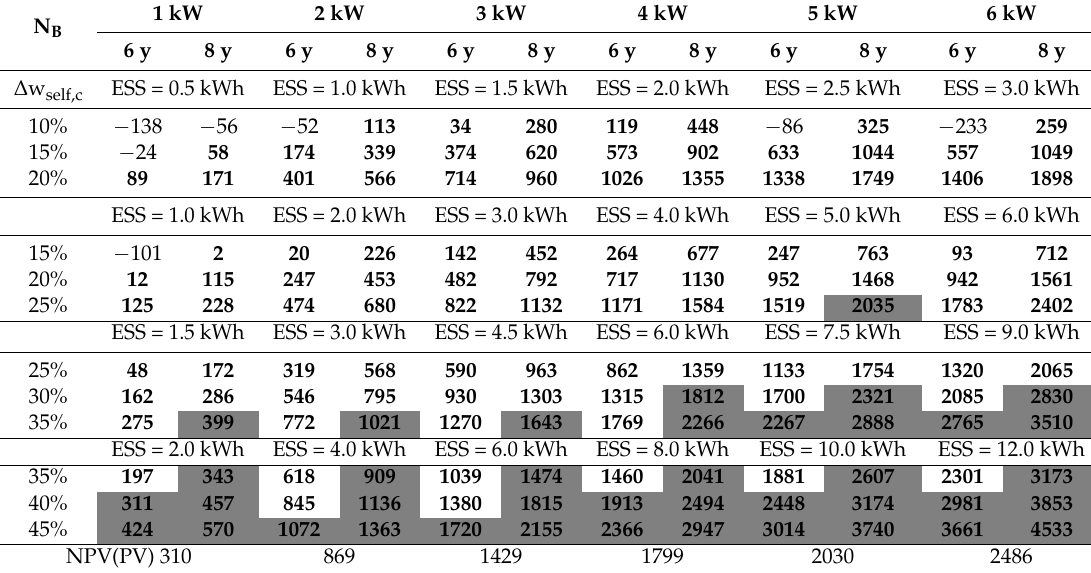
Table 6. Net Present Value ( € ) of integrated PV-battery systems with reduced regional subsidies.